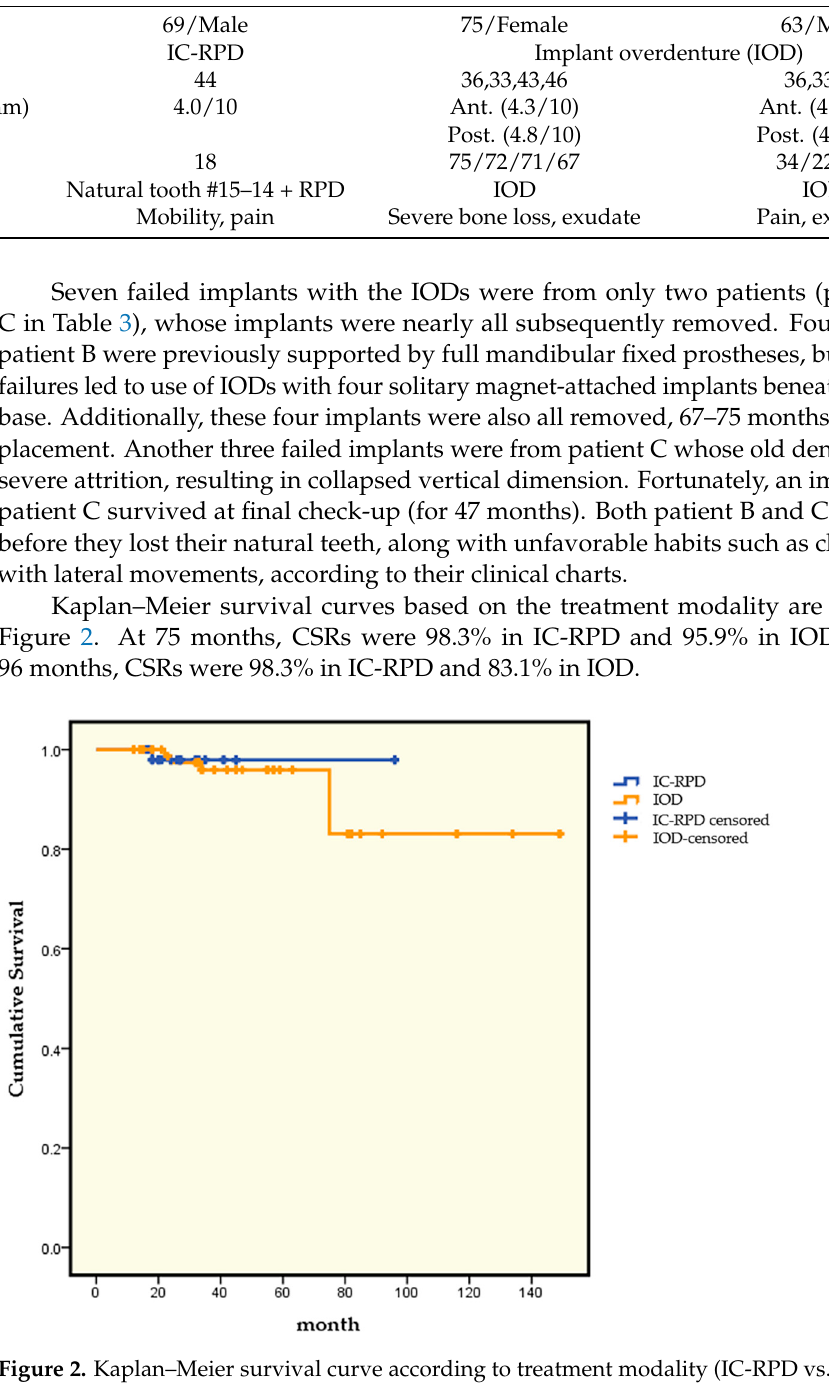
Table 3. The specific information of the 8 failed implants.